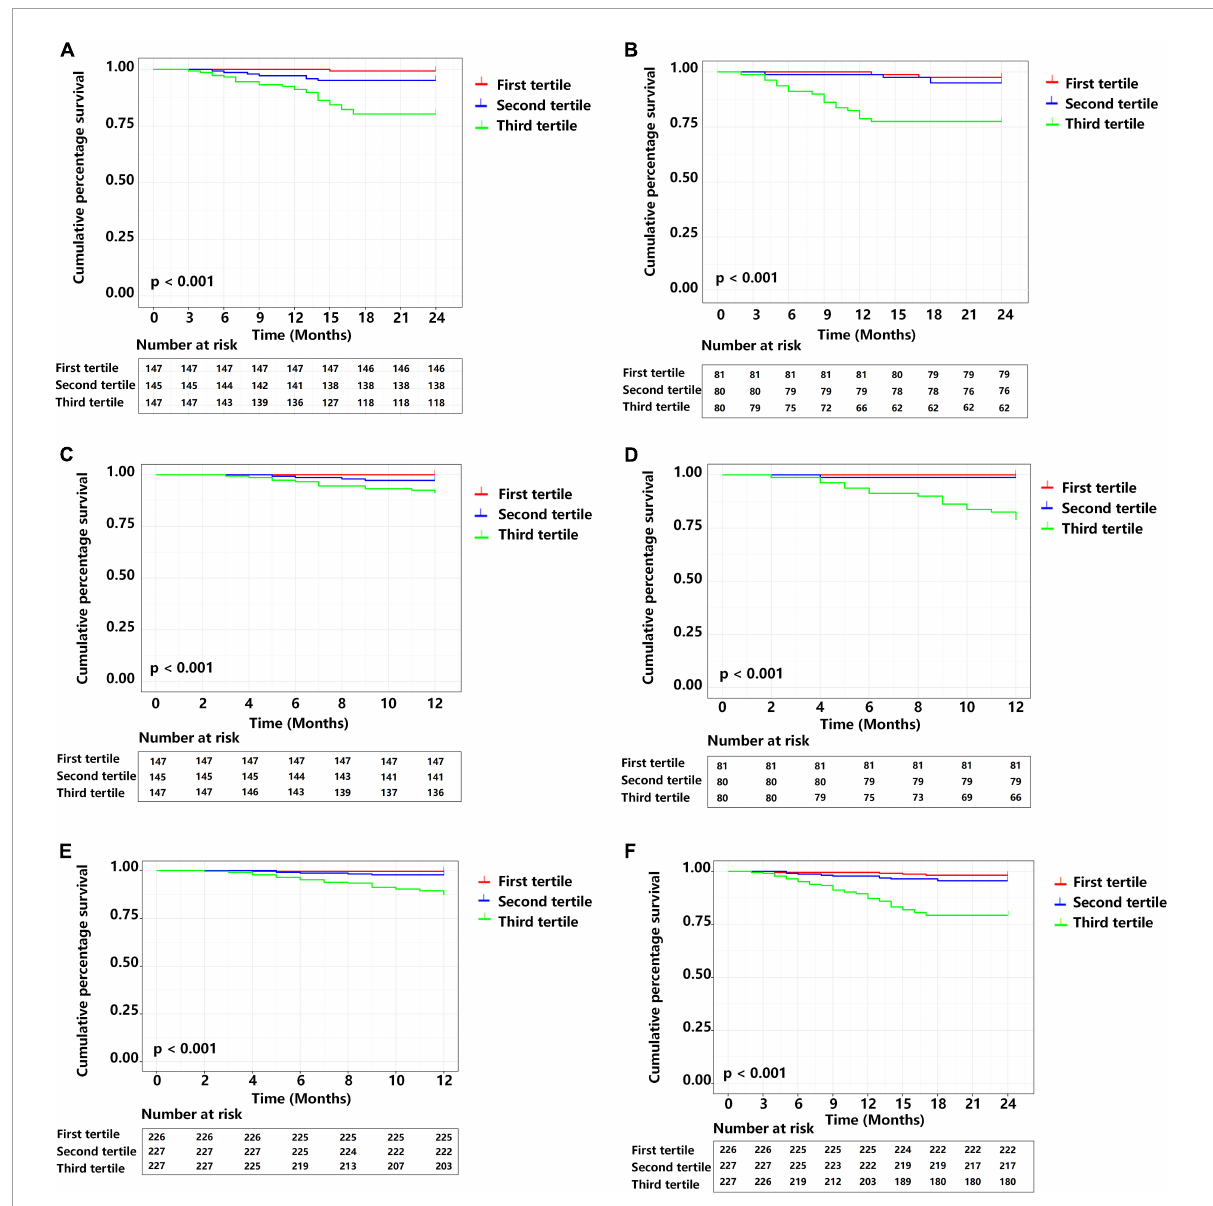
FIGURE7 Cumulative MACE-free survival of patients in different prognostic index (PI) tertiles. (A) Two year survival in the development cohort. (B) Two year survival in the external validation cohort. (C) One year survival the development cohort. (D) One year survival the external validation cohort. (E) One year survival in the complete cohort. (F) Two year survival in the complete cohort. Central illustration. Smart wearable electronic devices that use visual and personalized model-based risk assessment and an integrated approach that considers heart rate variability and clinical data (traditional risk factors) could allow patients to receive 24-h real-time personalized home telemonitoring and receive improved clinical